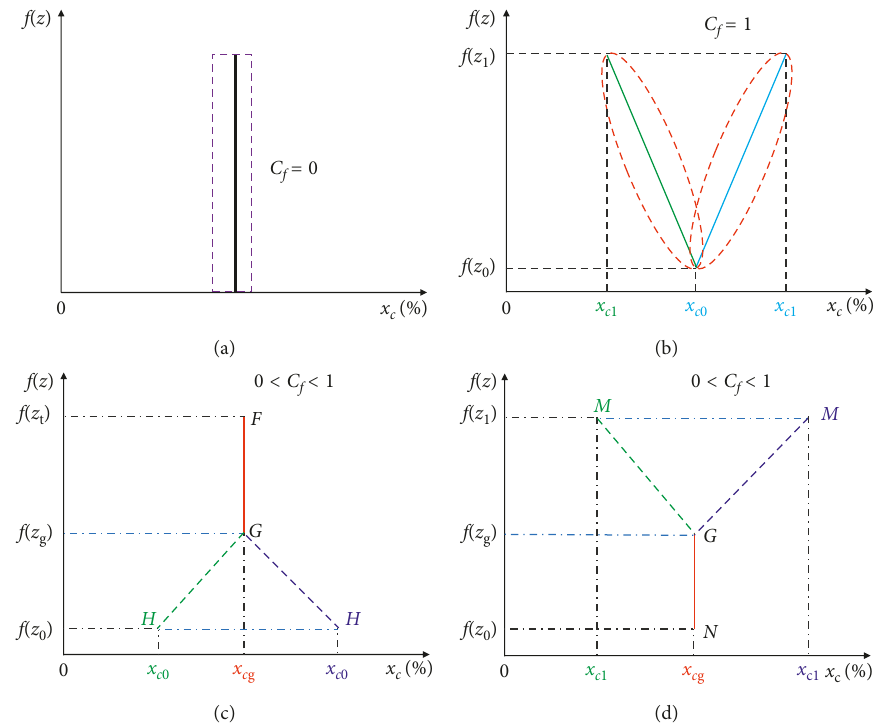
Figure 10: Corresponding simplified model for different crystal spatial distributions: (a) tensile failure; (b) shear failure; (c) first tension and then shear; (d) first shear and then